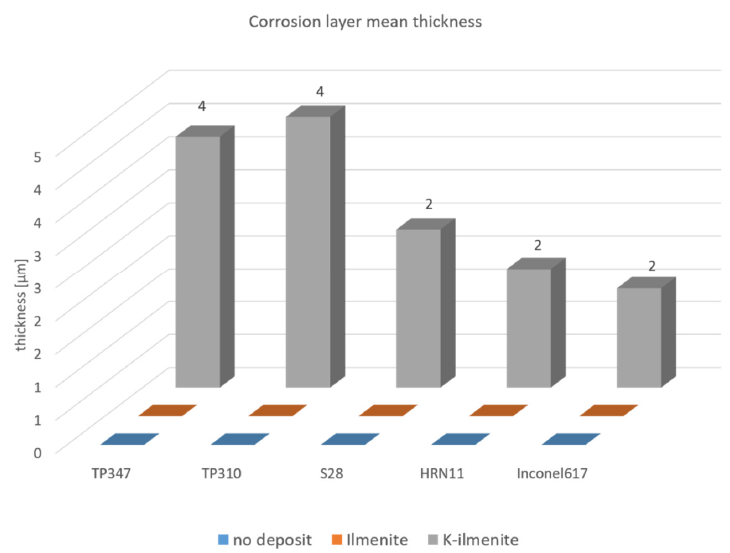
Figure 10. Mean thickness of oxide layer [µm] of samples exposed in dry air at 700 °C for 168 h.